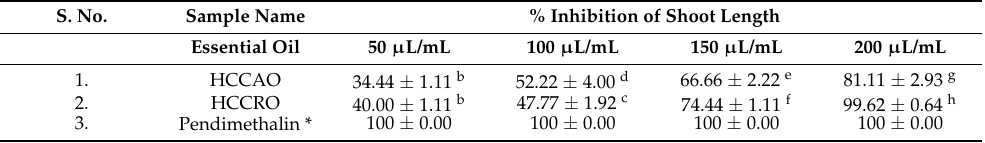
Table 12. Mean percent inhibition of shoot length of HCCAO and HCCRO.